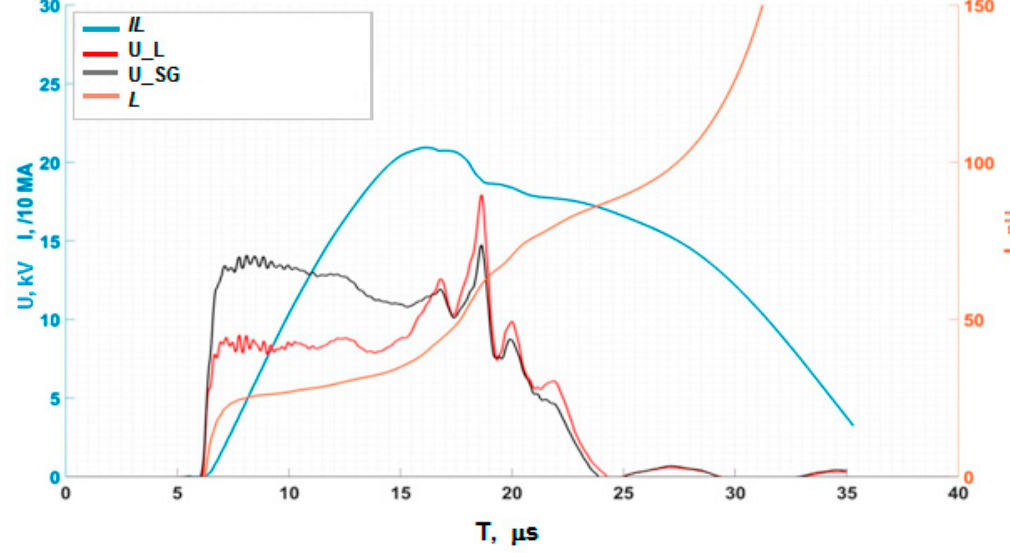
Figure 1. Oscillograms of current in the load ( I L —blue solid line), and voltage on the PPA (U_L—red line) and on the discharger (U_SG—black line) for left axis with respect to the changing inductance of the load ( L —brown line) for right axis.